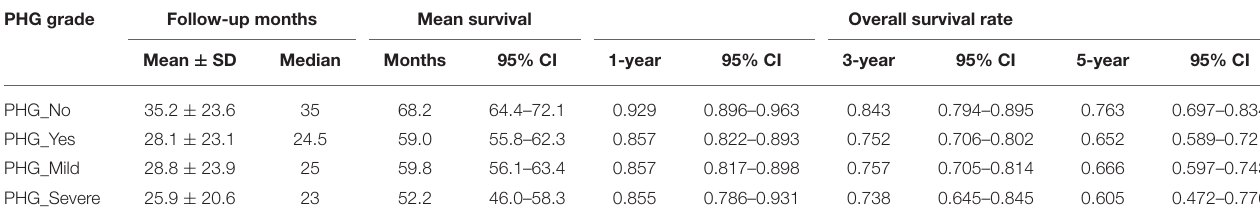
TABLE 3 | Survival rate based on PHG presence and